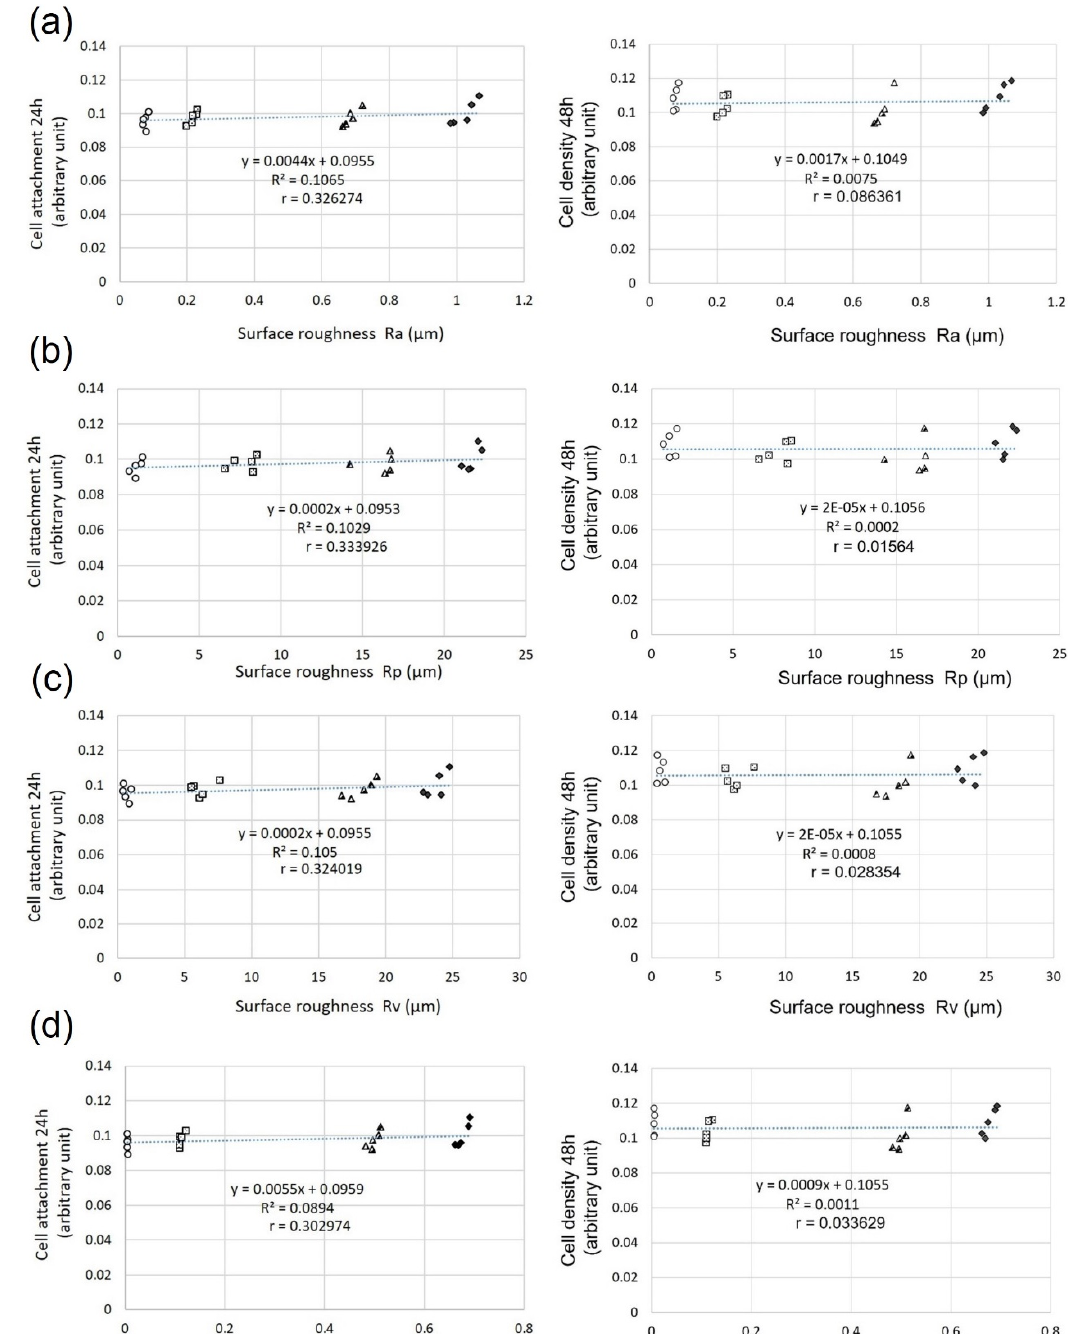
Figure 4. Relationship between cell attachment and surface roughness: ( a ) 24 h Ra (R = − 0.326), 48 h Ra (R = 0.086); ( b ) 24 h Rp (R = − 0.333), 48 h Rp (R = 0.015); ( c ) 24 h Rv (R = 0.324), 48 h Rv (R = 0.028); ( d ) 24 h Sa (R = 0.302), 48 h Sa (R = 0.033).